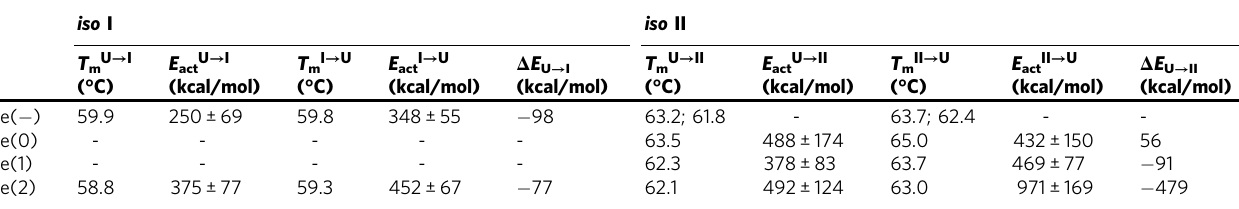
Thermodynamic and kinetic parameters of the thermal assembly (U → I and U → II) and disassembly (I → U and II → U) of domain A derived by analysis of the temperature-dependent FRET pro fi les in both the FRETI and FRETIIlabelingstrategies.Themeltingtemperatures( T m ,in°C)have beencalculatedfrom the fi rst derivativeofthe thermalpro fi les.The T m valuesforthe coolingandmelting processof individual constructs are approximately equal in the iso I form, while they differ of about 2°C in the iso II form, denoting the higher reversibility of the former over the latter species. Activation energies ( E act , in kcal/mol) from the unfolded (U) to the folded state (I or II) and viceversa have been calculated applying the model-free isoconversional Friedman-Ozawa method (see Suppl. Note 1). Mean energies and standard deviations were obtained from sets of 50 to 450 values, whose linear correlation was larger than 0.98. Not accessible data are indicated by a (-)